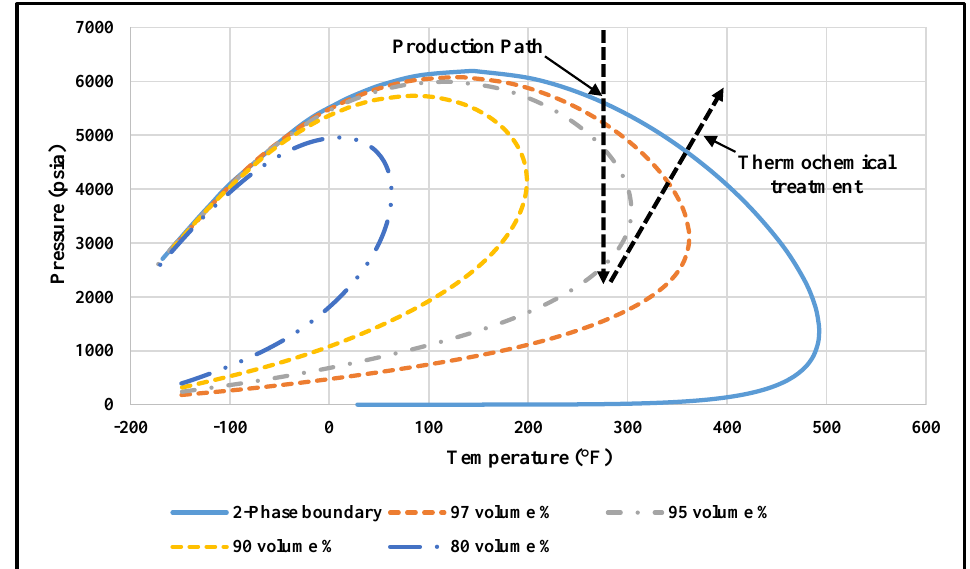
Figure 19. Revaporization of condensate liquid due to thermochemical treatment.